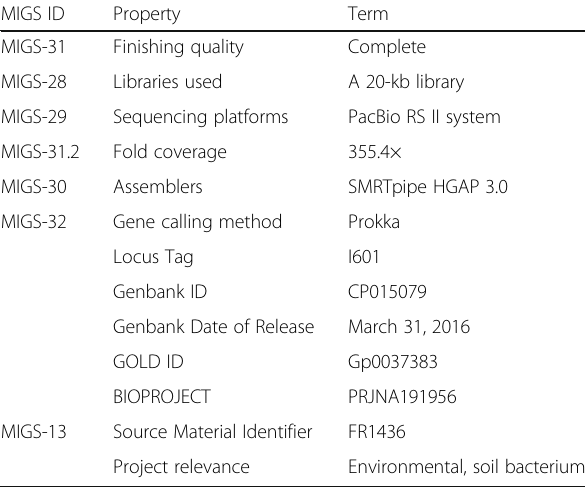
Table 2 Project